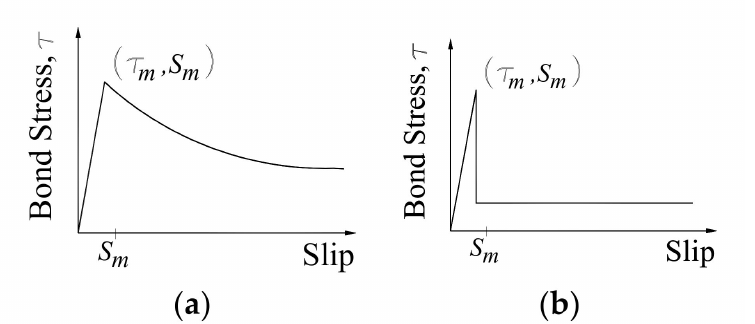
Figure 9. Bond-slip characteristics of NSM FRP to concrete: ( a ) failure inside concrete; ( b ) failure at bar-adhesive interface